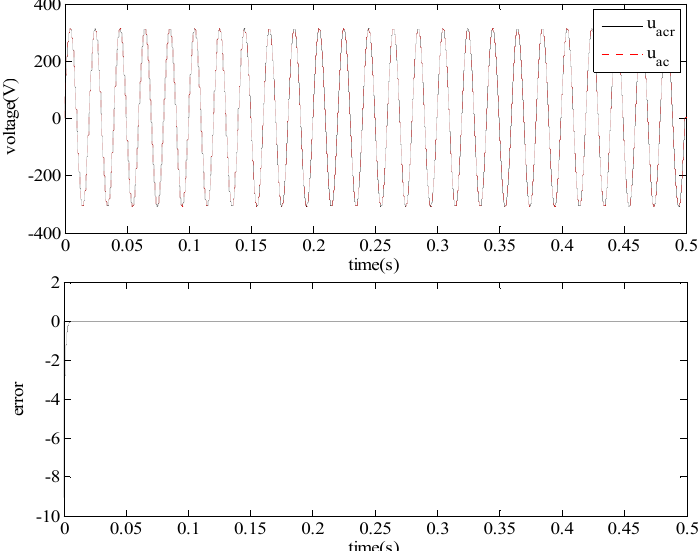
Figure 10. Performance of the DC-AC inverter with the FNNGFTSMC scheme.